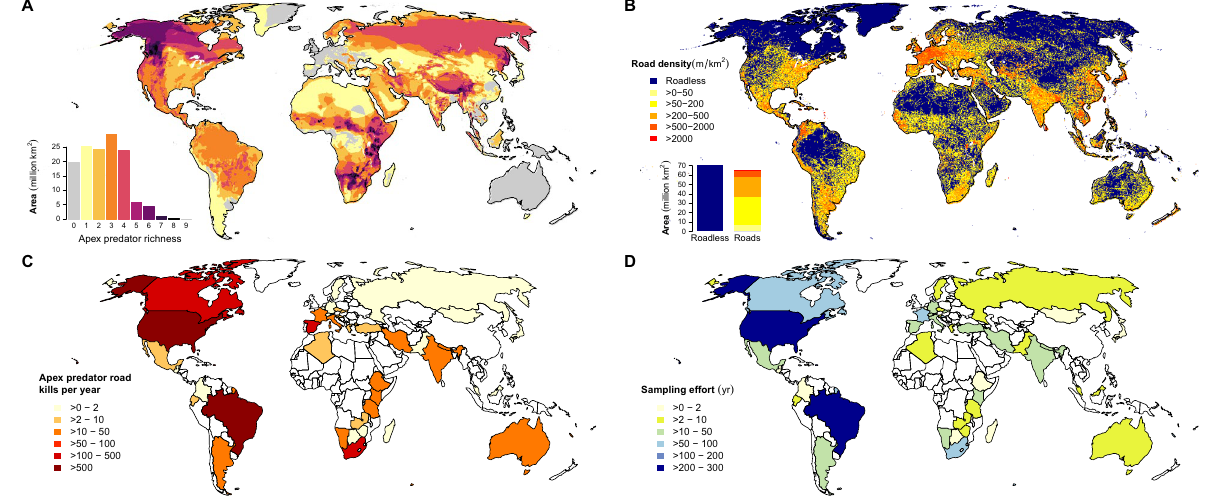
Figure 1. ( A ) Global apex predator richness ( n = 36) calculated from IUCN species distribution maps 18 . ( B ) Global road density at 5-arcmin resolution, equivalent to approximately 8 km in the tropics, representing four road types (highways, primary, secondary, and tertiary roads), data from the Global Roads Inventory Project 11 . ( C ) Total number of Wildlife-Vehicle Collisions (WVC) of apex predators recorded in a single year (between 1963 and 2021) for each country with available WVC data. ( D ) WVC sampling effort per country, referred to the sum of years of study (ranging from 1963 to 2021). Maps were generated in R software v4.0.3 (https:// www.R- proje ct.